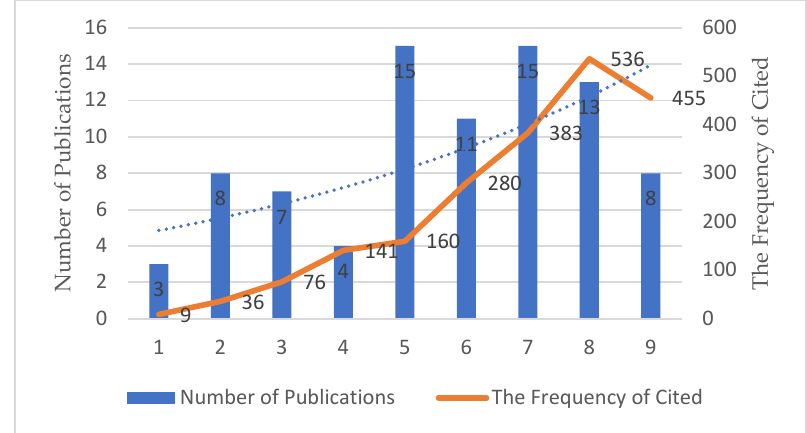
Figure 2. The number of publications and the frequency of cited by year.